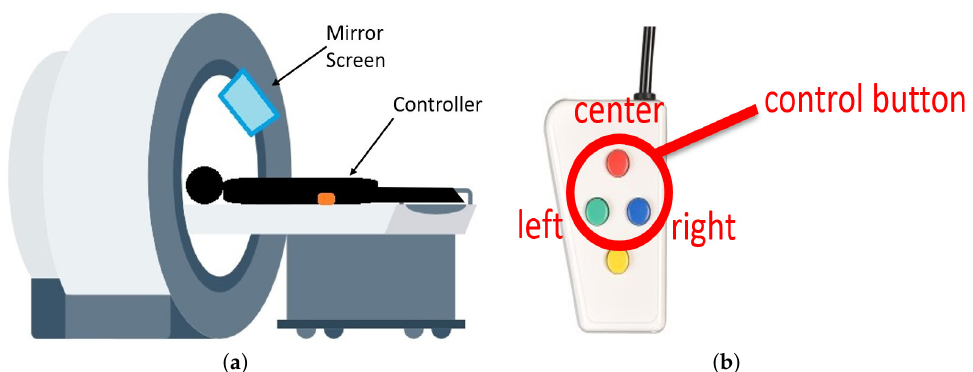
Figure 2. fMRI machine setup used in the experiments [28]. ( a ) Mirror screen in the fMRI machine; ( b ) Controller used in the experiment while in the fMRI